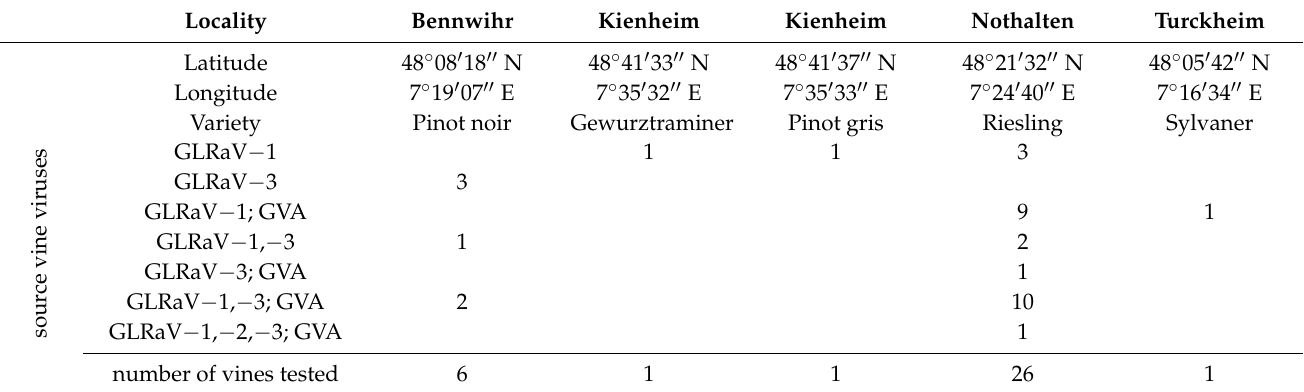
Table 1. Location of the plots sampled for Pulvinaria vitis nymphs and number of recipient vines inoculated in infectivity tests according to virus content of source